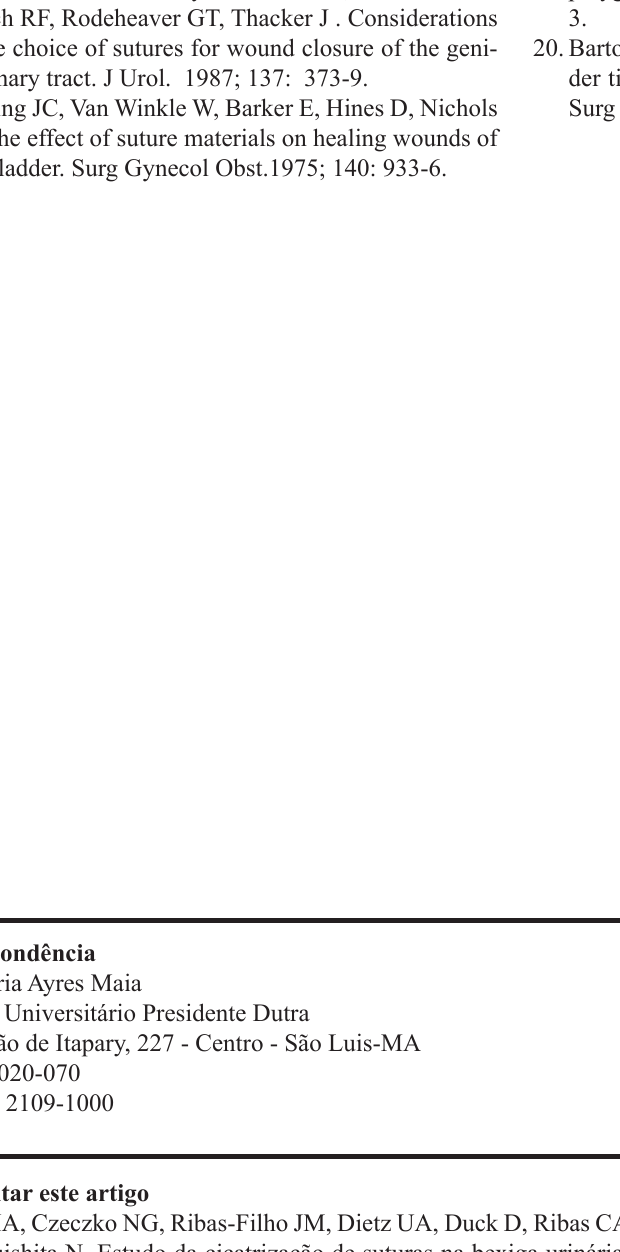
Figuras coloridas disponíveis em